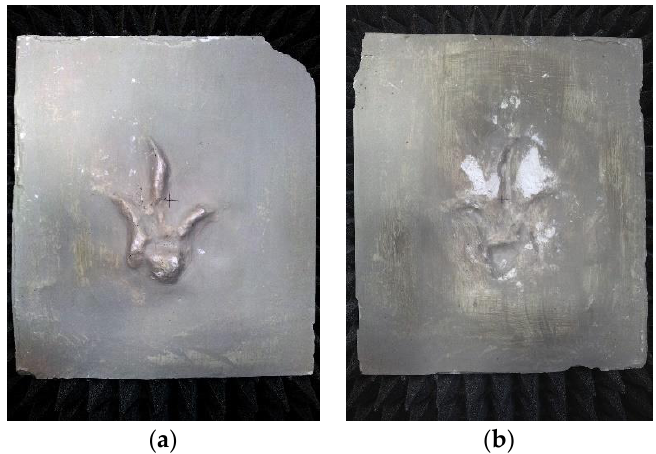
Figure 33. Cast ( a ) and mold ( b ) of the Anamoepus dinosaur footprint. Experiments with only the cast or mold with clean plaster surfaces conducted in all frequency bands showed clear radar images that gave better results at higher frequencies. From this experimental investigation and from the support of the simulations of digital fingerprint models, we can believe that the MW holographic radar is suitable for performing non-contact scans of areas in which the traces are even partially exposed. The ability to scan without contact is an important advantage, considering the fragility of the thin layers that covers the sequences of the impressions and the difficulty of recording and reproducing them digitally when they have low relief. To highlight the ability to discover hidden footprints, the mold of the implant was coupled with the plaster cast to reproduce the situation in nature. This imaging (Figure 34) was most successful when the mold and cast were separated by a thin (less than 1 mm) slip of clay or sand (as is common for real tracks).